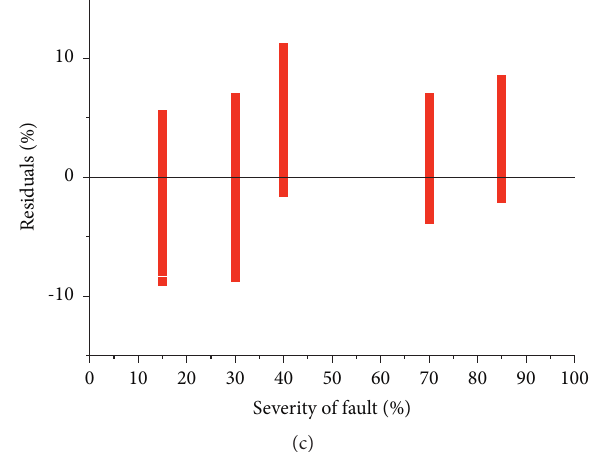
Figure 11: Residual plots of the severity of the fault estimator for the ANFIS model (a), RBFN model (b), and LSTM model